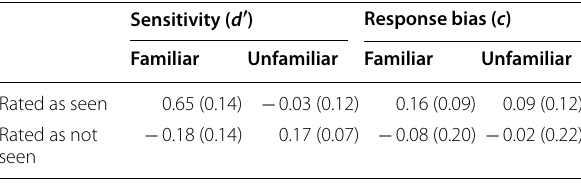
Descriptive statistics [mean(standard error of the mean)] for the measures sensitivity ( d ′ ) and response bias ( c ) Results are shown separately for familiarity and cases in which participants rated the faces as seen or not seen in the study phase (Question 1).